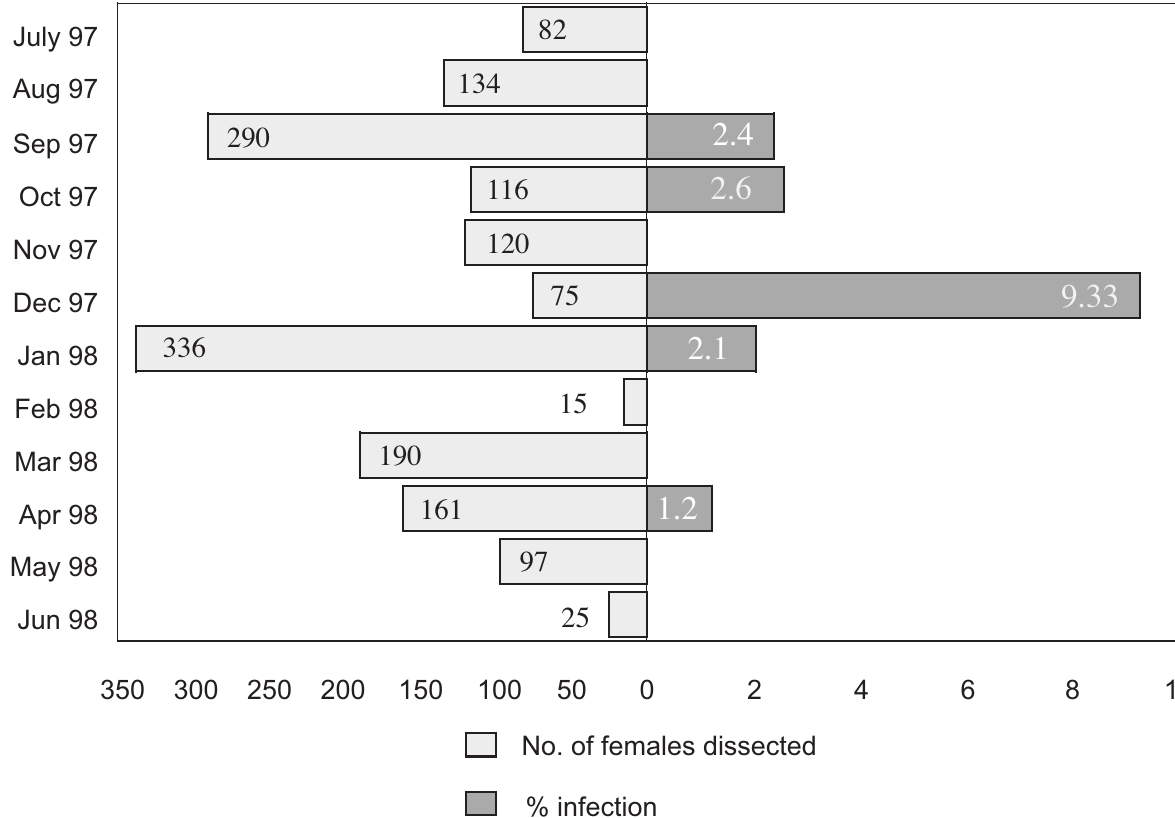
Fig. 3. – Monthly rates, July 1997-June 1998, of naturally infected Lutzomyia spinicrassa in Catárnica, Táchira State, Venezuela.